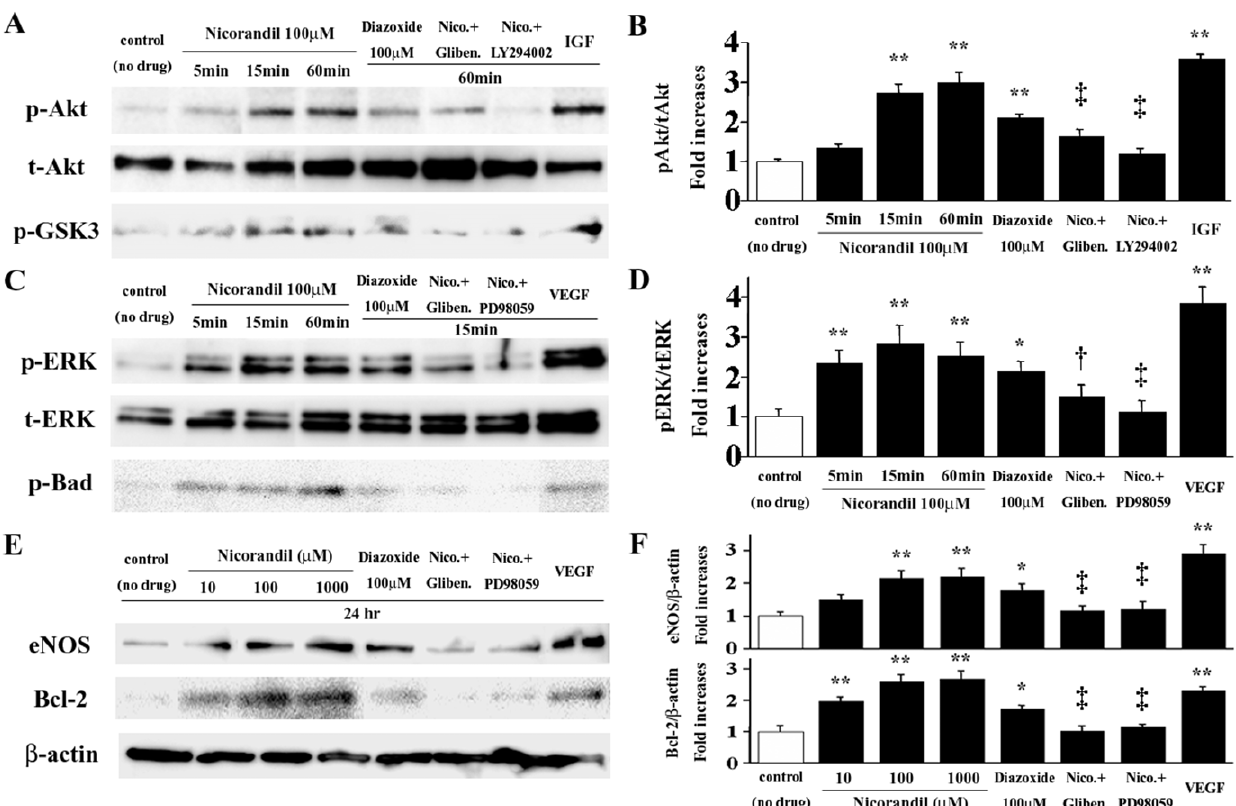
Figure 8. Nicorandil activates the PI3K/Akt and ERK pathways in HUVECs. ( A ) Nicorandil and diazoxide increased Akt serine-473 and GSK-3 phosphorylation in the serum-starved HUVECs, while these effects of nicorandil were blocked by glibenclamide and the PI3K inhibitor LY294002. ( B ) The Akt phosphorylation (p-Akt) data are expressed as fold increases normalized to the total Akt (t-Akt) expression. IGF, insulin-like growth factor (positive control). ** P , 0.01 vs. control (no drug); { P , 0.01 vs. 60-min nicorandil treatment. ( C ) Nicorandil and diazoxide also increased ERK1/2 threonine-202/204 and Bad serine-112 phosphorylation in the HUVECs, while these effects of nicorandil were blocked by glibenclamide and the MEK inhibitor PD98059. ( D ) The ERK phosphorylation (p-ERK) data are expressed as fold increases normalized to the total ERK (t-ERK) expression. * P , 0.05 and ** P , 0.01 vs. control (no drug); { P , 0.05 and { P , 0.01 vs. 15-min nicorandil treatment. ( E ) In serum-starved HUVECs treated with nicorandil for 24 h, the expression of eNOS and Bcl-2 was upregulated in a concentration-dependent manner, while these effects were blocked by glibenclamide, LY294002 (data not shown), and PD98059. ( F ) eNOS and Bcl-2 expression data are expressed as fold increases normalized to the b -actin expression. * P , 0.05 and ** P , 0.01 vs. control (no drug); { P , 0.01 vs. 100- m mol/L nicorandil